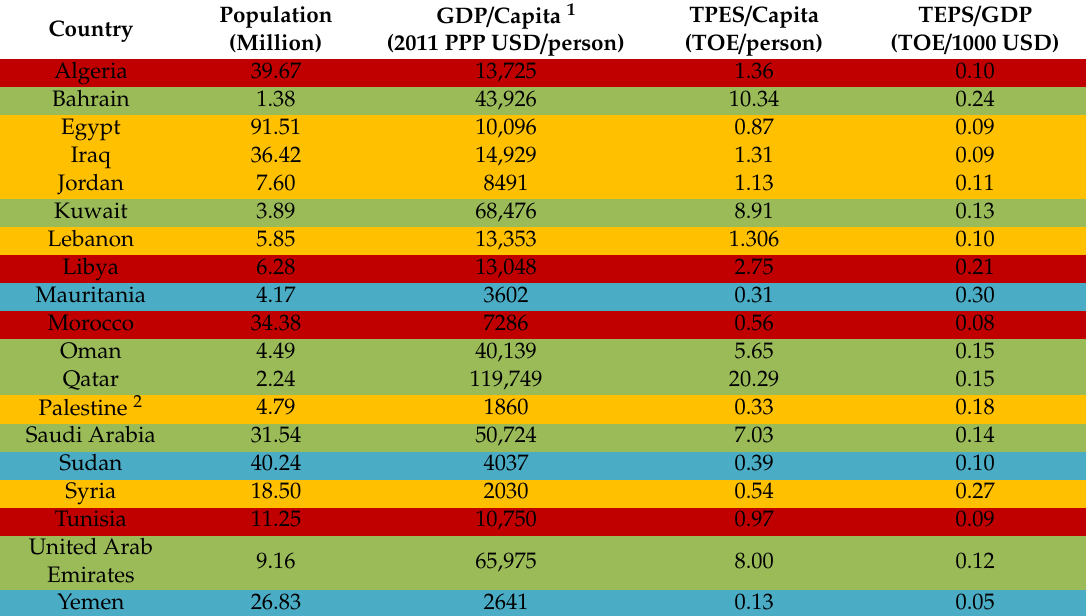
Table 2. Summary of basic macro-economic indicators for Arab countries for 2015 (colors refer to the sub-regions: green for GCC, yellow for Mashreq, maroon for Maghreb, and blue for LDC).